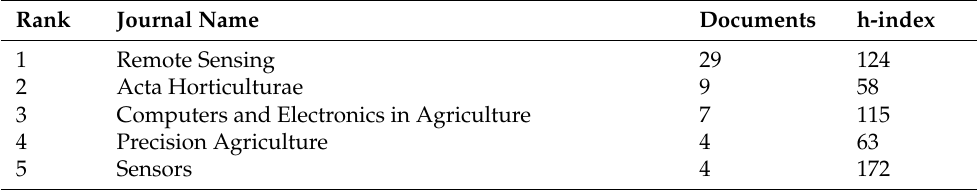
Table 5. Most preferred journals on adopting